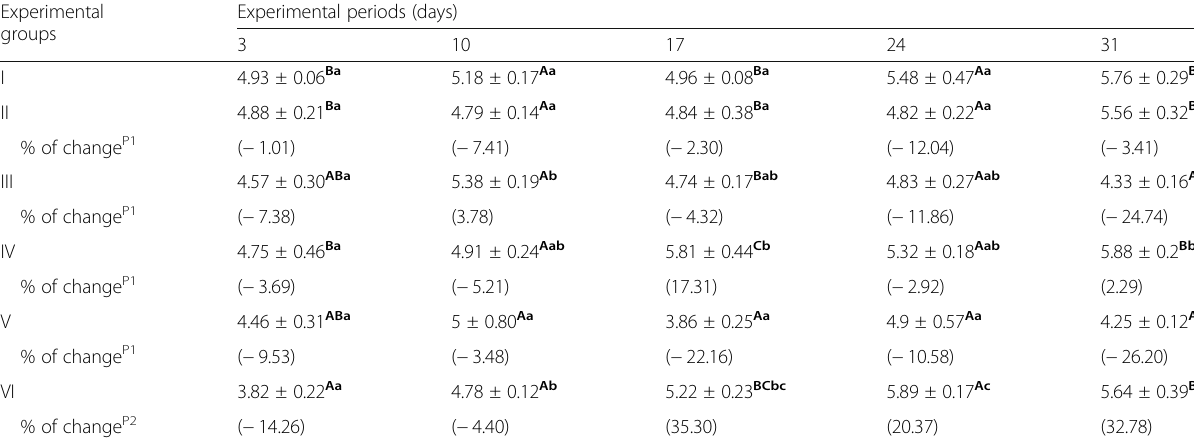
Table 2 WBCs count (10 9 /L) in the experimental groups at the experimental periods Experimental Experimental periods groups